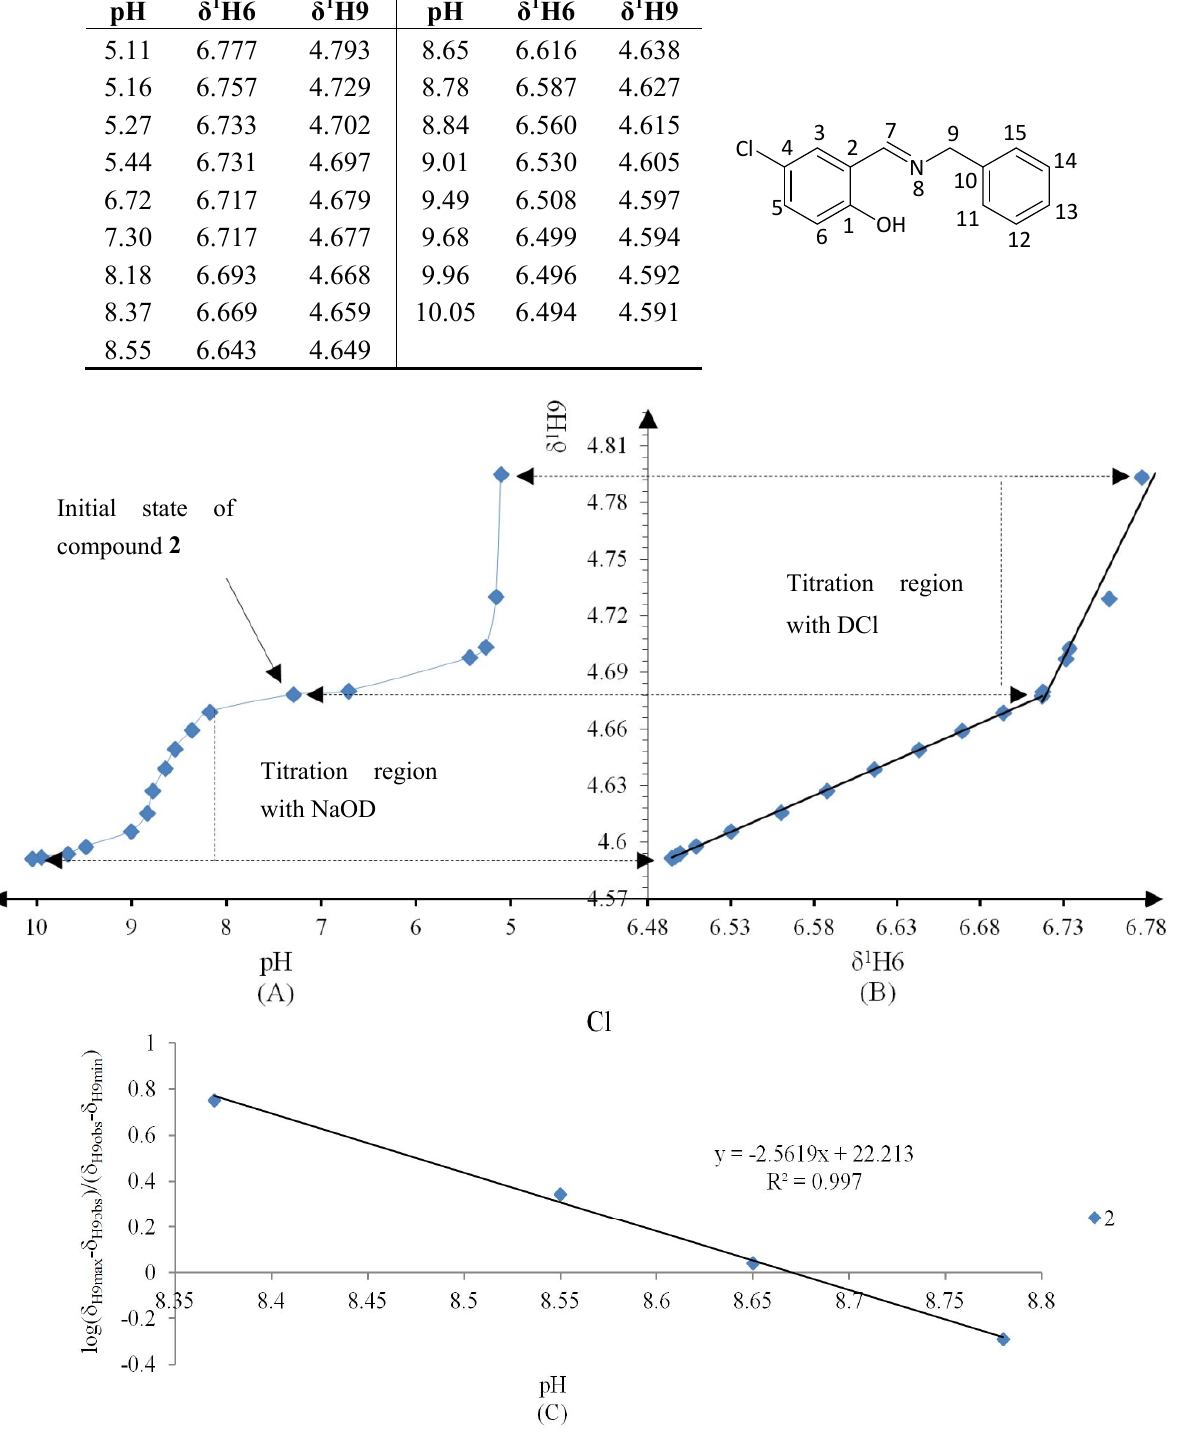
Figure 7. ( A ) titration curve (pH vs. δ 1 H9); ( B ) δ -diagram with Perrin model analysis ( δ 1 H6 vs. δ 1 H9) and ( C ) plot of the semilogarithmic Henderson-Hasselbalch equation (pH vs. log[( δ − δ )/( δ − δ )]) of compound 2 (R = Cl). Only compound 2 H9max H9obs H9obs H9min was titrated with DCl